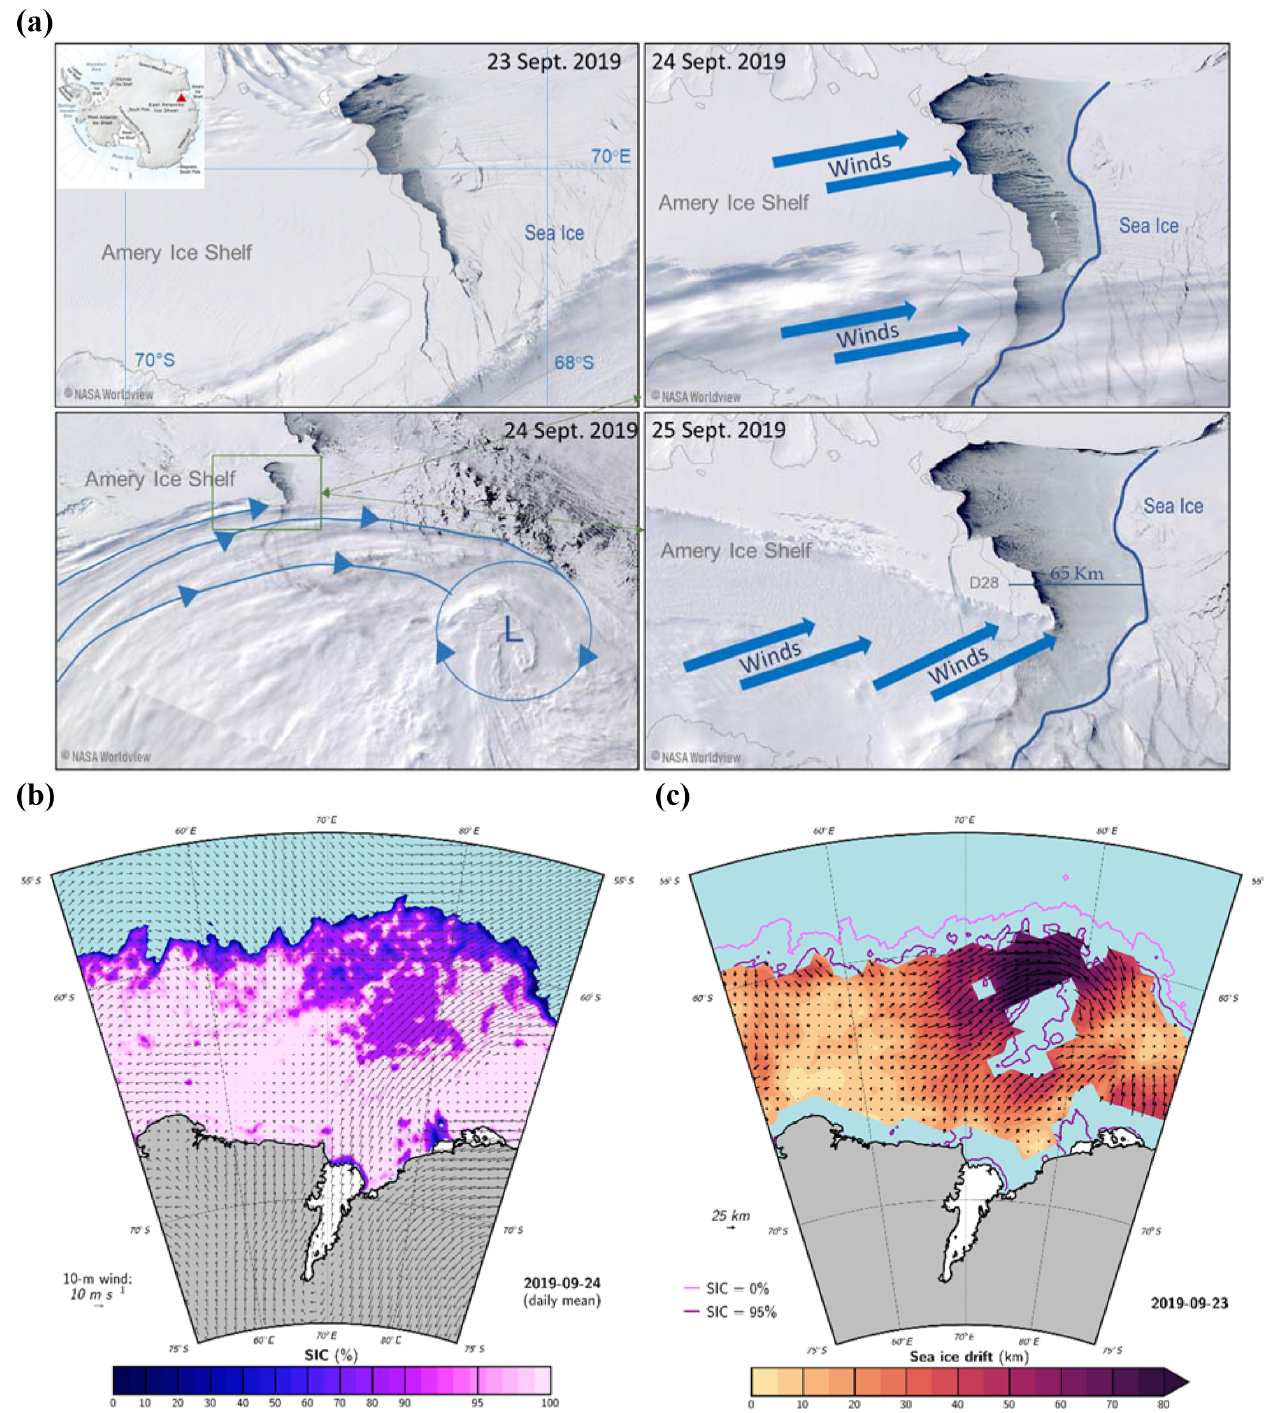
Figure 8. (a) MODIS satellite visible imagery of the Amery Ice Shelf showing the ice shelf before the calving on 23 September 2019 and during the calving on 24–25 September 2019. Image credit: NASA Worldview. (b) Satellite-derived sea ice concentration (SIC) and ERA5- derived daily mean 10m winds in vectors over 55–75 ◦ S and 50–90 ◦ E on 24 September 2019 at 00:00UTC. (c) Satellite-derived daily sea ice drift velocity in colors and direction in vectors on 23 September 2019. The solid pink contour is the 0% sea ice concentration contour, and the solid purple contour is the 95% sea ice concentration